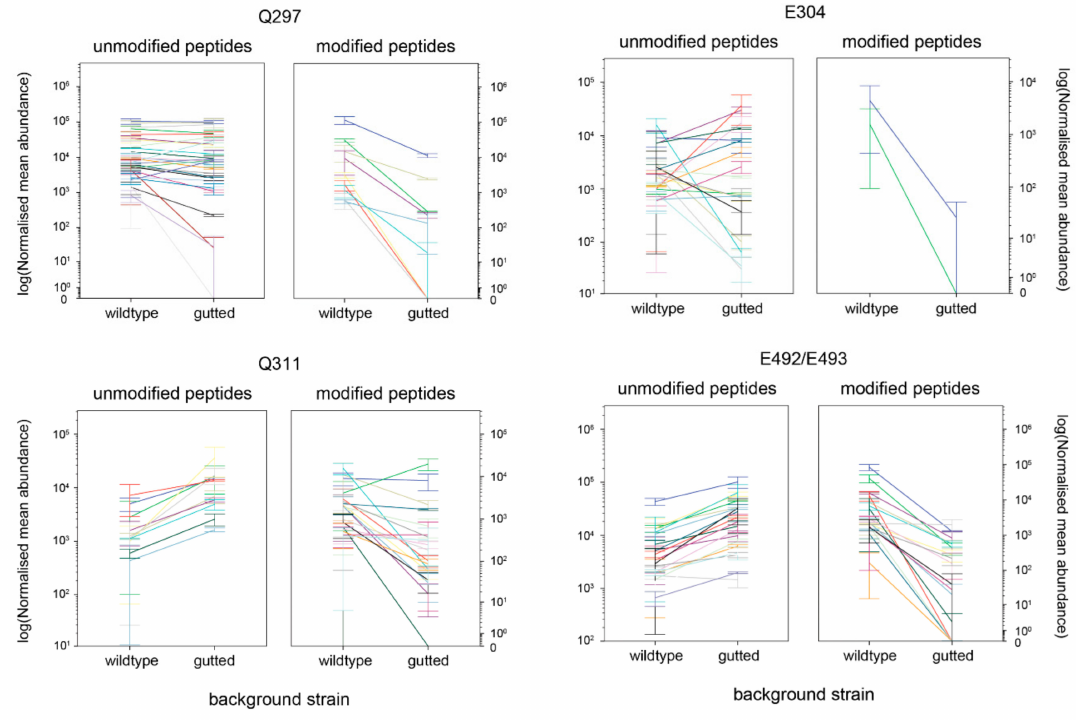
Figure 3. Relative abundance of each E. coli Tsr peptide (modified or unmodified) in the two backgrounds, RP437 (wild-type) and RP1091 (gutted of chemotaxis genes) identified in MS / MS that contains a glutamate or glutamine site known to be adaptation sites. Sites E492 and E493 are combined, as it is di ffi cult to resolve data for a glutamate pair. Each measurement was in duplicate, with error bars showing the two values. Each colour within a plot represents one peptide containing that